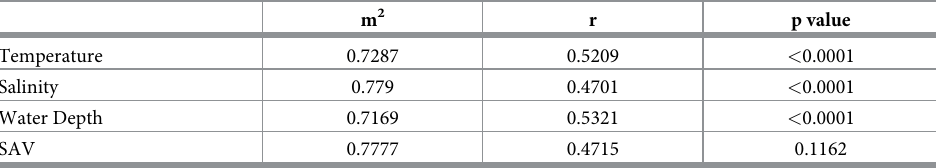
Table 4. Results of Procrustean analysis of density (shrimp m -2 : LN([x+1]) relative to temperature (˚C), salinity (ppt), water depth (m), and SAV (% cover) including goodness-of-fit measure (sum of squares, m 2 ), correlation of the Procrustean rotation (r), and p value of the